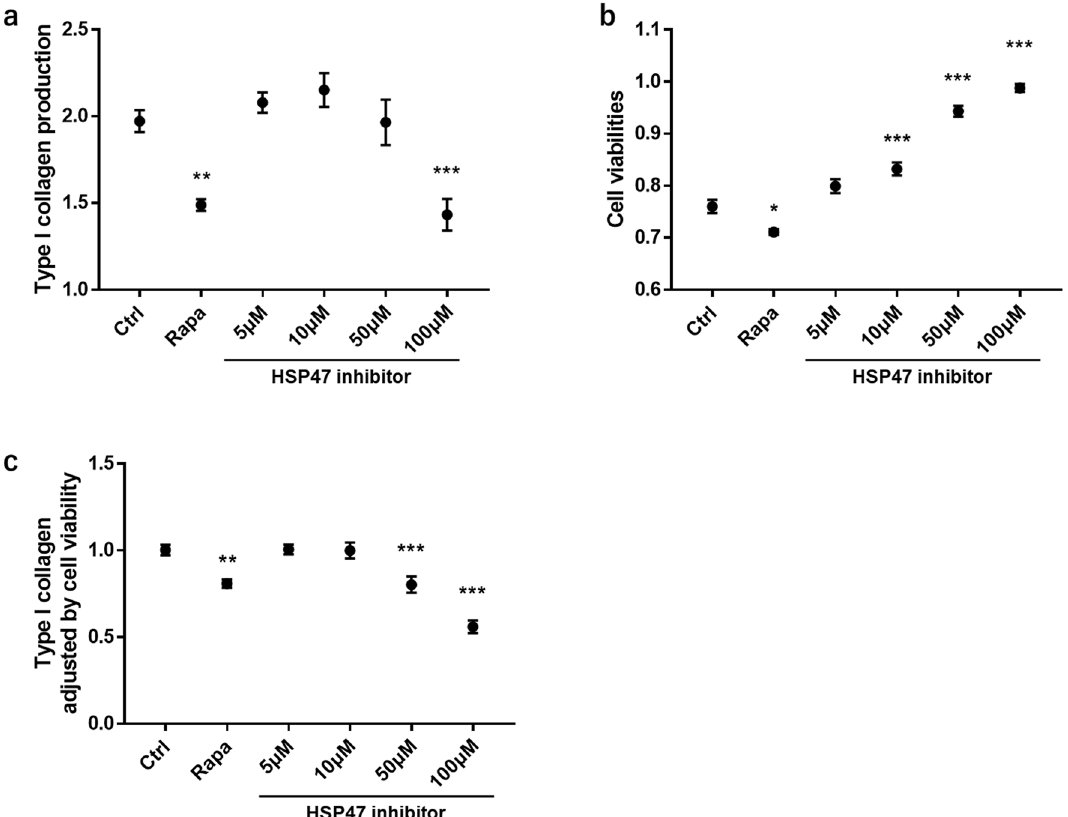
human fibroblast cells after 24 h of treatment. ( b ) Cell viabilities of human fibroblasts after treatment. ( c ) Type I collagen production adjusted by cell viabilities. Rapa, rapamycin; HSP, heat shock protein. *P < 0.05; **P < 0.01; ***P < 0.001 (one-way analysis of variance test with a post-hoc Dunn’s